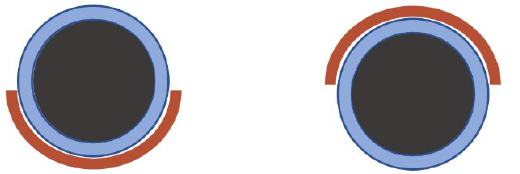
Figure 9. Positioning of the surface coil on the bottom ( left ) and the top ( right ) of the horizontally fixed 10 mm pipe.